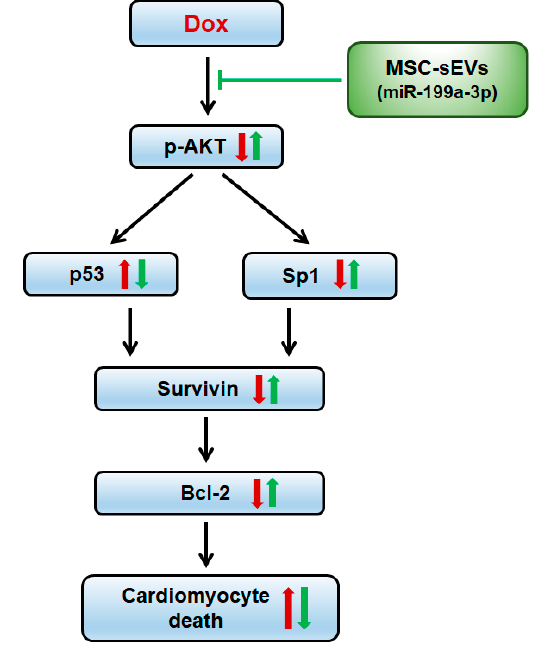
Figure 10. Schematic of the proposed role of MSC-sEVs in DOX − induced cardiomyopathy. In cardiomyocytes, DOX induces an increase in the transcription factor p53 and a decrease in Sp1 through Akt inhibition, thereby inducing cardiomyocyte death by downregulating the expression of survivin and Bcl2 related to cell survival. The miR − 199a − 3p in MSC − sEVs plays a key role in the protective effects of MSC − sEVs against DOX − induced cardiomyopathy, by upregulating survivin expression via regulating the Akt − Sp1/p53 signaling pathway.